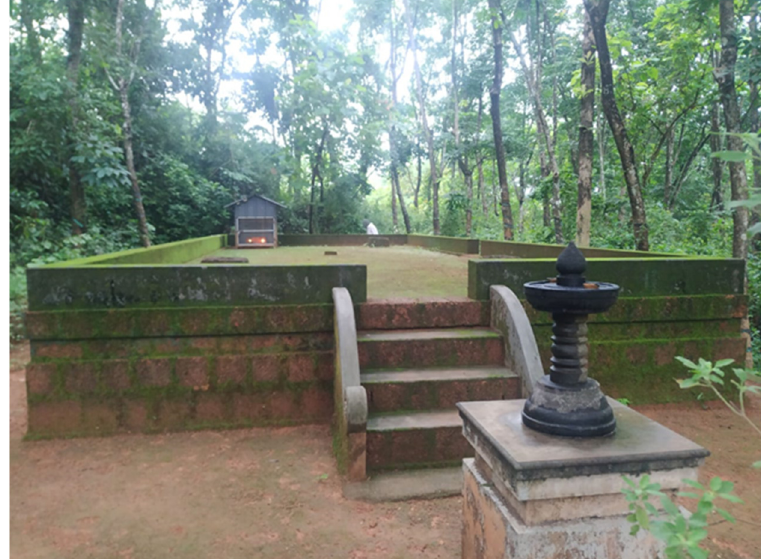
Figure 3. A traditional ka ḷ ari of the Panikkars. Photo by G. Sudev Sharman.